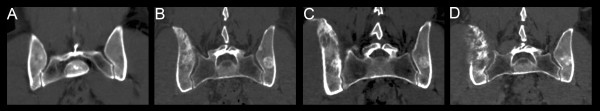
CT scans, coronal sections, showing growth of bone metastasis at different time points during the progression of the disease. (A) CT scan at the time of diagnosis, (B) after 9 weeks (C) after 16 weeks, and (D) after 24 weeks.